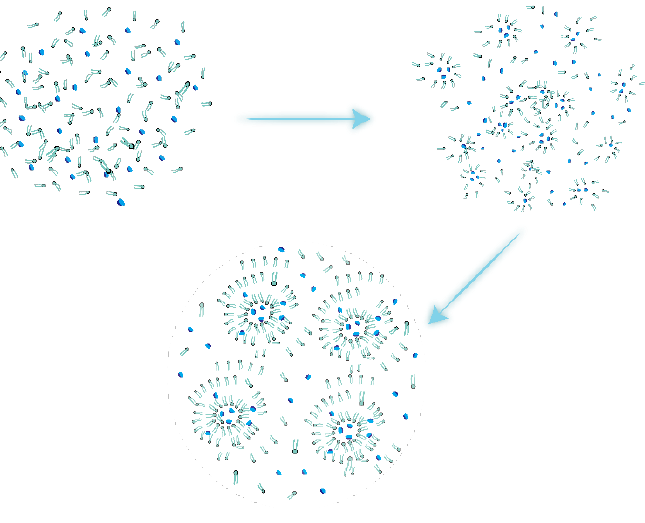
Figure 1. Liposome formation process.